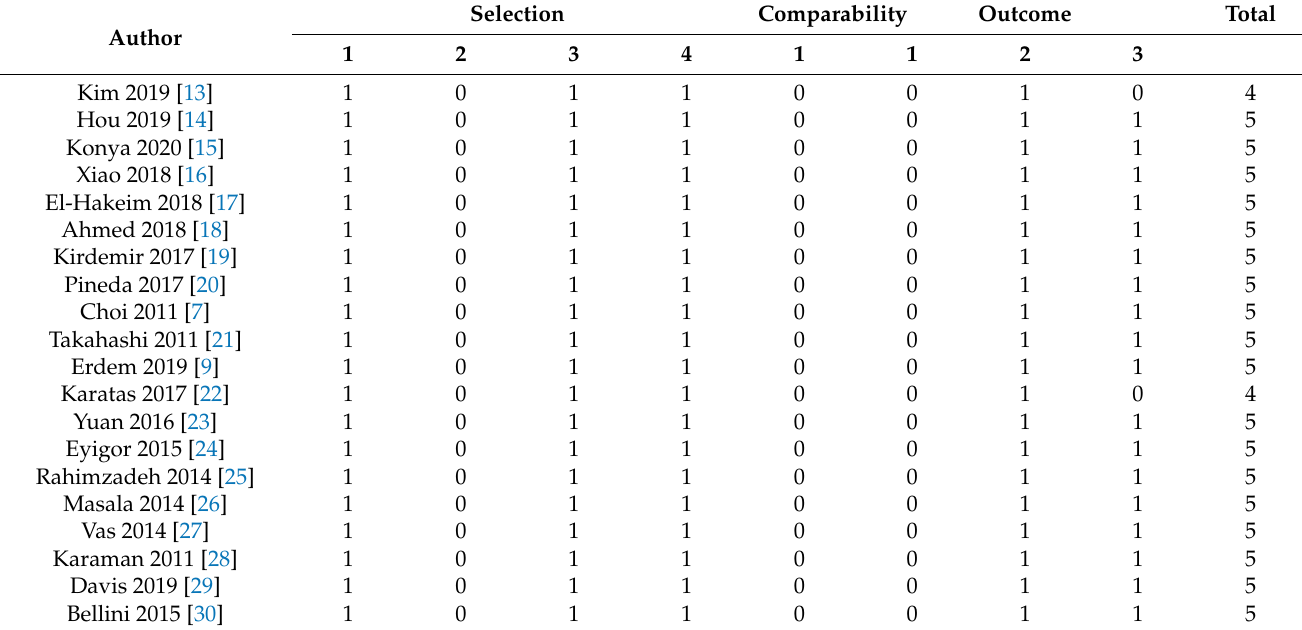
Table 2. Assessment of methodological quality by the Newcastle–Ottawa quality assessment scale for cohort